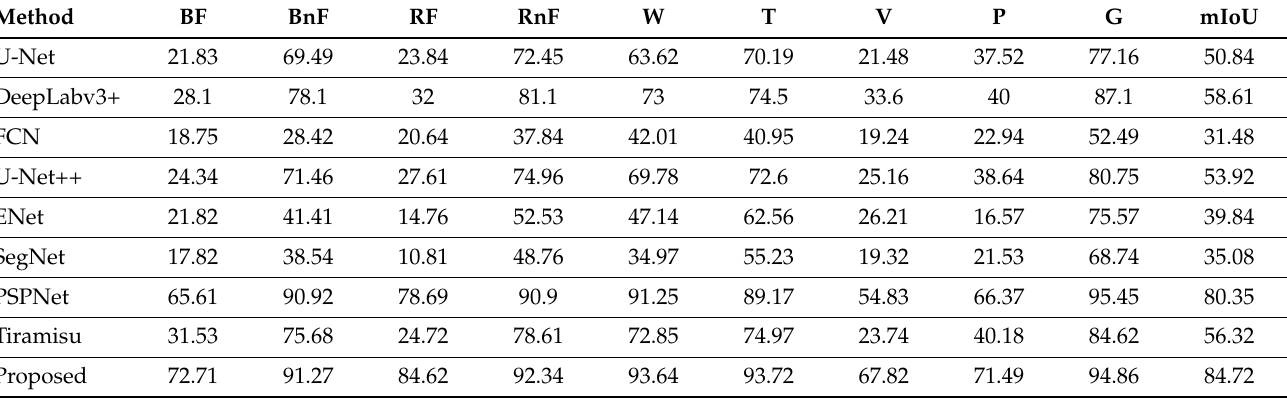
Table 3. Comparison of different methods using Jaccard index and mIoU. BF: Building—flooded, BnF: Building—non-flooded, RF: Road—flooded, RnF: Road—non-flooded, W: Water, T: Tree, V: Vehicle, P: Pool, G: